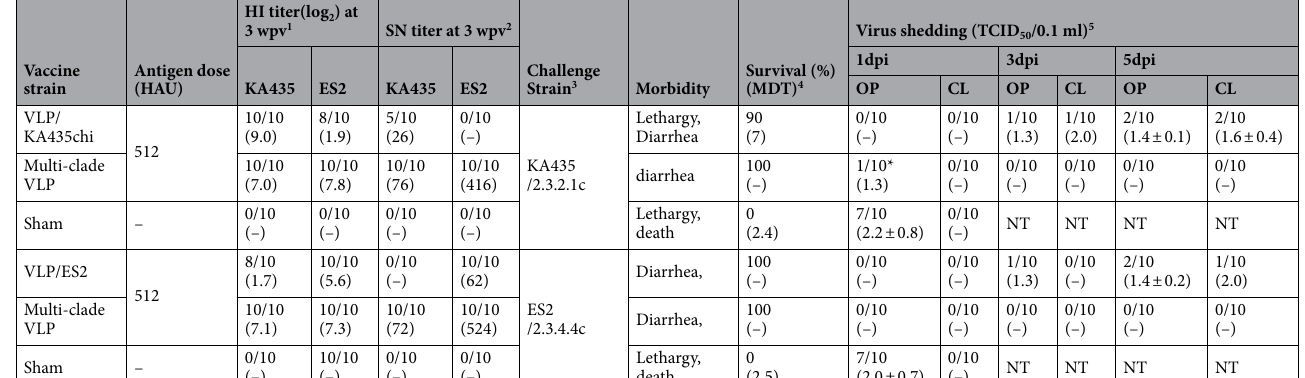
Table 2. Results among single and multivalent vaccinations against homologous and heterologous HPAI. HA hemagglutination activity, NT not tested, dpi days post-infection, OP oropharyngeal, CL cloacal, HI hemagglutination inhibition. *p value < 0.05. 1 No. serology positive/total survived in group (mean HI titer). 2 No. serology positive/total survived in groups (mean SN titer). 3 Homologous: same as vaccine strain; heterologous: different from vaccine strain. 4 MDT = mean death time (days). 5 No. virus positive/total in group (mean shed-virus